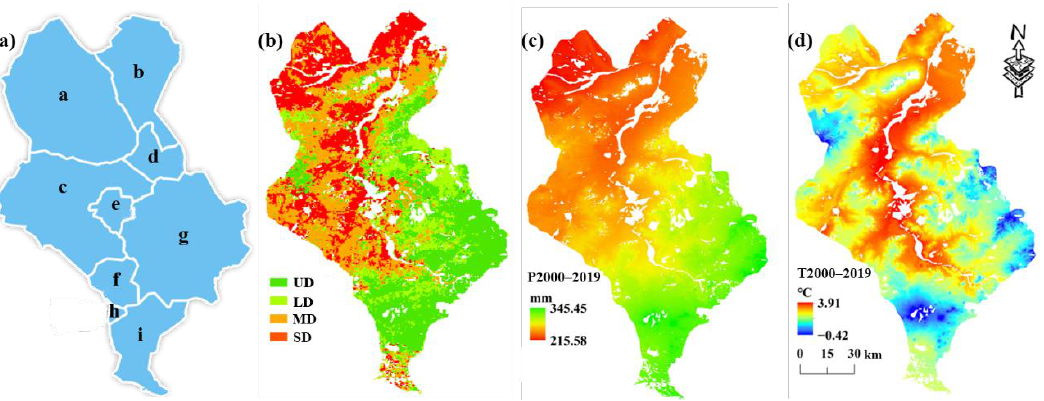
Figure 12. Regional priority of grassland ecological restoration. ( a ) Schematic diagram of towns distribution; ( b ) spatial distribution of grassland degradation in the study area, from 2015 to 2019; ( c ) spatial distribution of precipitation in the study area, from 2000 to 2019; ( d ) spatial distribution of temperature in the study area, from 2000 to 2019. UD, undegraded grassland; LD, lightly degraded grassland; MD, moderately degraded grassland; SD, severely degraded grassland; T, temperature; P, precipitation. a, Arshan Baolige town; b, Chaokewula Sumu; c, Baoligen Sumu; d, Maodeng Ranch; e, Xilinhot city; f, Beilike Ranch; g, Baiyinxile Ranch; h, Xilingol ranch station; i, Baiyinkulun Ranch.